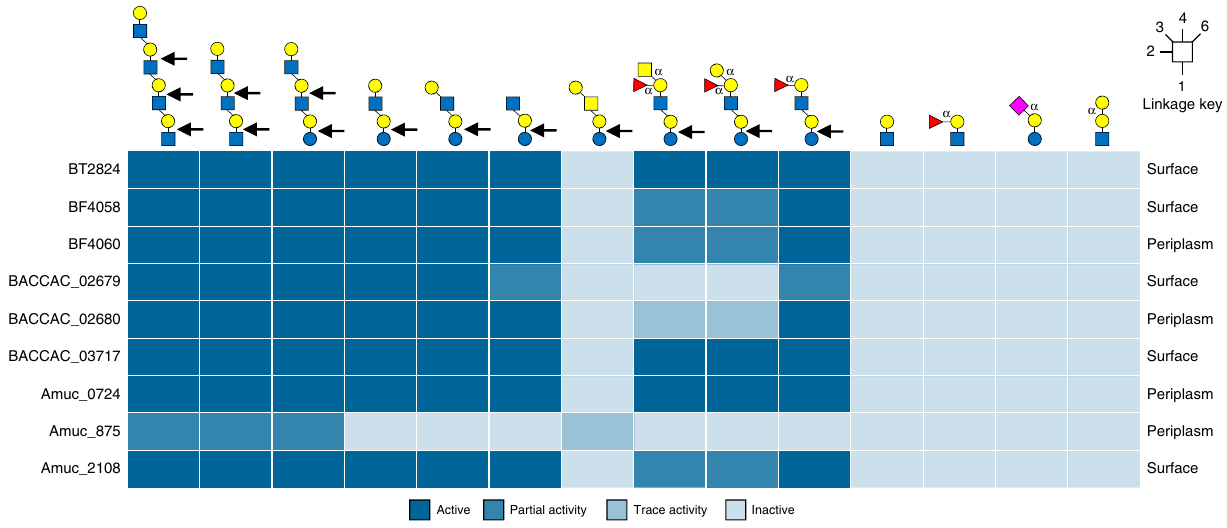
Fig. 4 Heat map showing the activity of the GH16 O-glycanases against different oligosaccharides. The data summarises the speci fi city of the GH16 O- glycanases described in this report. From left to right the glycans are TetraLacNAc, TriLacNAc, paraLacto-N-neohexaose, Lacto-N-neotetraose, Lacto-N- tetraose, Lacto-N-triose, Gal β 1,3GalNAc β 1,3Gal β 1,4Glc tetrasaccharide Blood group A hexasaccharide, Blood group B hexasaccharide, Blood group H pentasaccharide, LacNAc, Blood group H tetrasaccharide II, 3-sialyllactose and P1 antigen. The linkages are β unless otherwise labelled and the bonds cleaved are indicated by the black arrows. Partial and trace activity are the estimation of greater than or less than 50% degradation, respectively, under the assay conditions used. A more detailed summary can be found in Supplementary Table 4. The predicted cellular locations of each enzyme is indicated on the far right of each